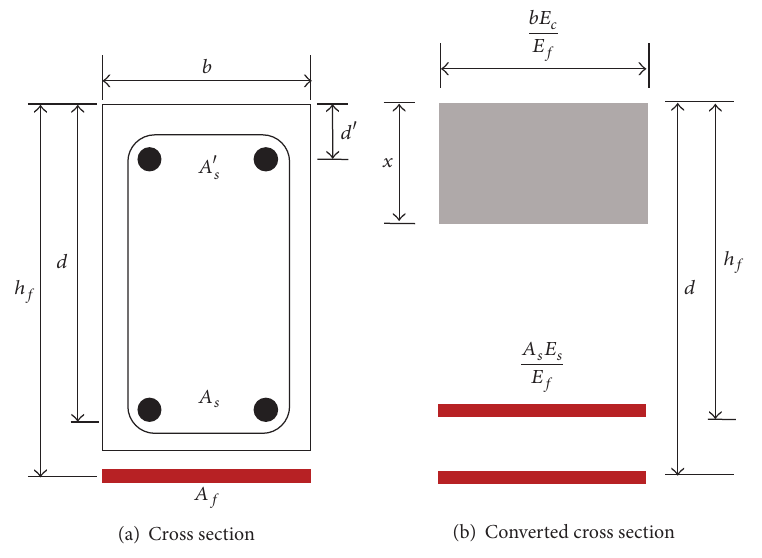
Figure 3: The converted cross section for fiber sheets.